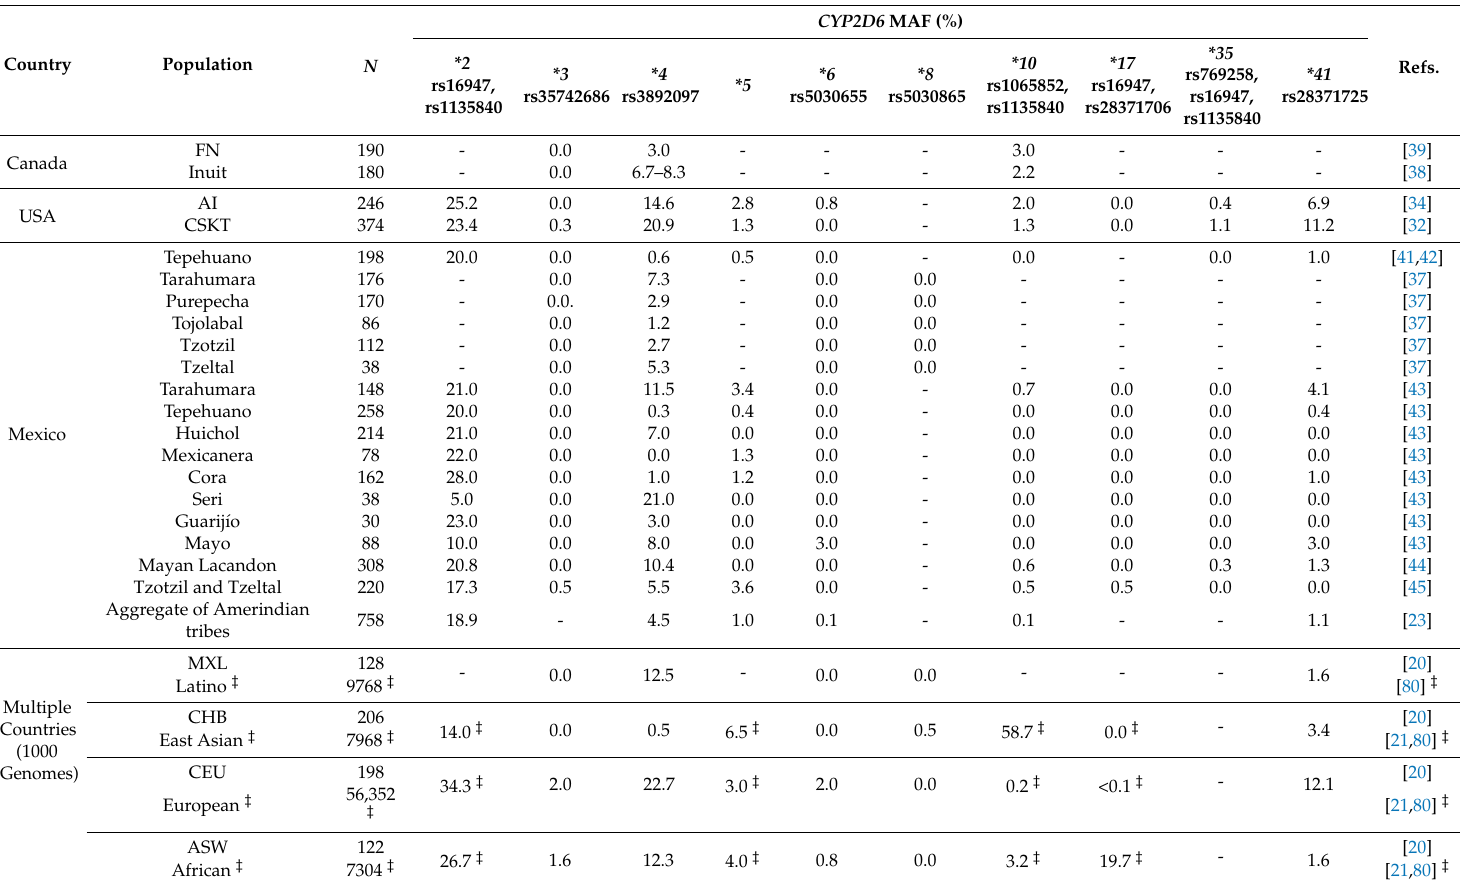
Table 9. Comparison of CYP2D6 allele frequencies Indigenous North American populations to global populations from the 1000 Genomes Project [20]. N represents the number of alleles. Not shown is CYP2D6*7 (rs503086), as it was not detected or not tested for in the Indigenous populations studied. Global populations are abbreviated as follows: African Ancestry in Southwest US (ASW); Utah residents with Northern and Western European ancestry (CEU); Han Chinese in Beijing, China (CHB); Mexican Ancestry in Los Angeles, California (MXL). For alleles not captured by 1000 Genomes (noted by ‡), the frequencies were extracted from Exome Aggregation Consortium [80] and for alleles defined by multiple variants, the frequencies reported in Zhou et al. [21] using LDLink software [81] were